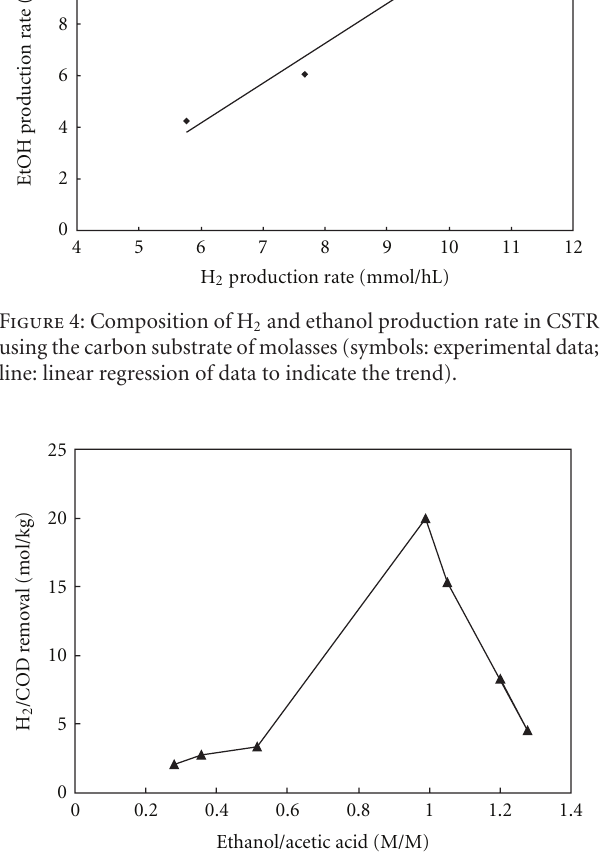
Figure 5: The influence of the ratio of ethanol to acetic acid on the hydrogen production rate by COD removal.